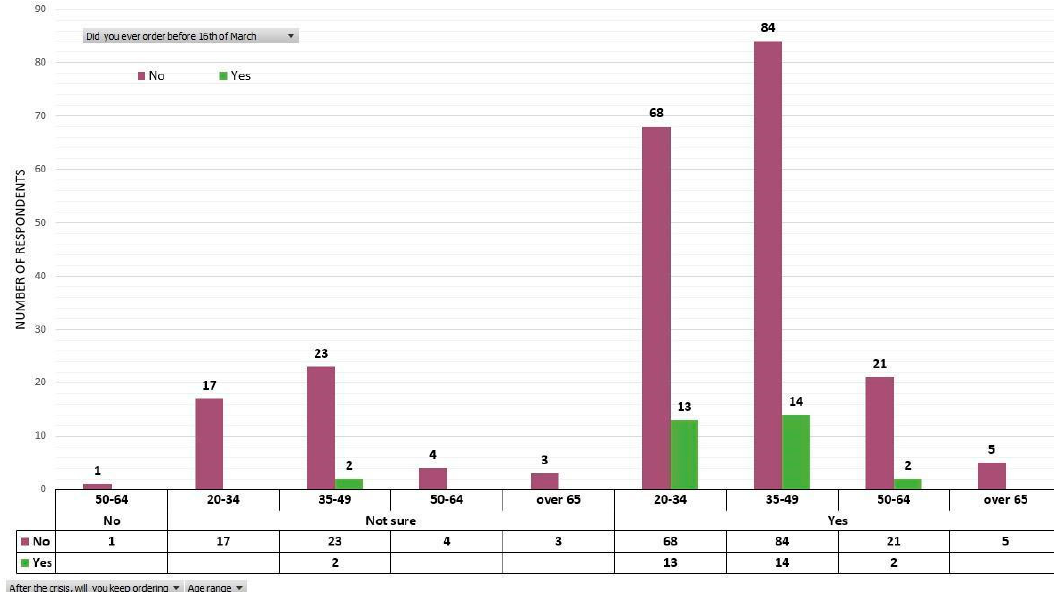
Figure 6. The clusters of those who stated that they bought or did not buy fresh vegetables from local producers with direct delivery before the 16 of March, distributed according to age categories and statement that they will buy or not directly from local producers after the COVID-19 crisis.